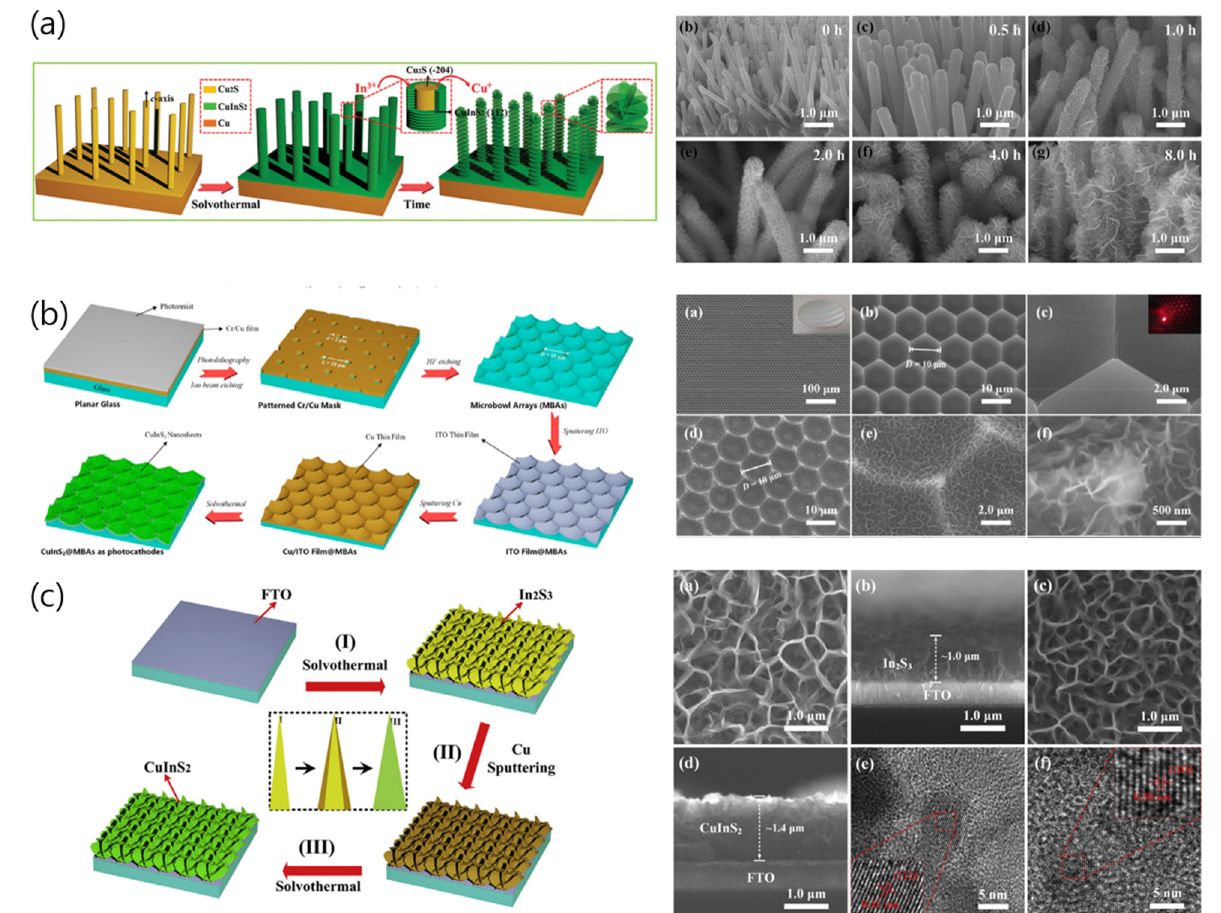
Figure 5. Schematics illustrating the preparation of various nanostructure-controlled CuInS 2 films and scanning electron microscopy (SEM) images of the films: ( a ) CuInS 2 nanorods array by facile gas–solid reaction/solvothermal [28], ( b ) photoelectrode based on 3D micro bowl arrays using CuInS 2 nanosheet array grown using solvothermal method as photocatalyst [26], and ( c ) CuInS 2 nanosheet arrays fabricated from In 2 S 3 self-sacrificial templates using solvothermal and sputtering [25]. Reproduced from ref. [28] and ref. [26] with permission from Elsevier. Reproduced from ref. [25] with permission from Wiley-VCH.